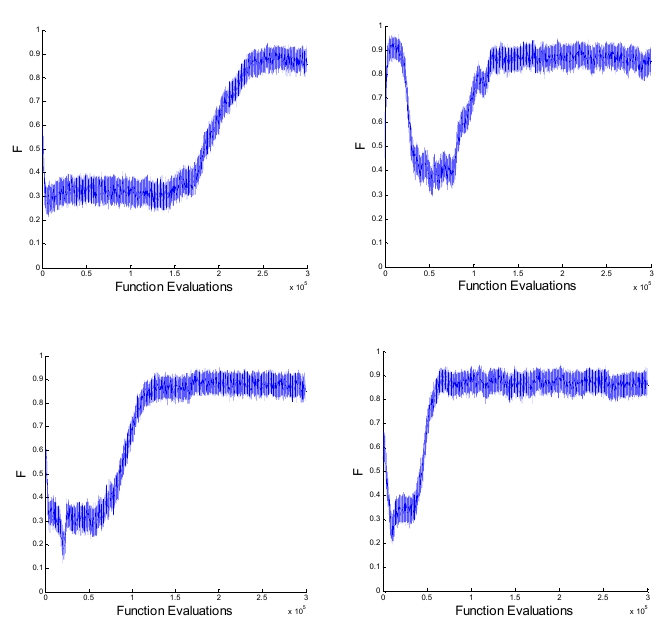
Figure 4. How the scaling factor F changes f1, f10, f21, f28.